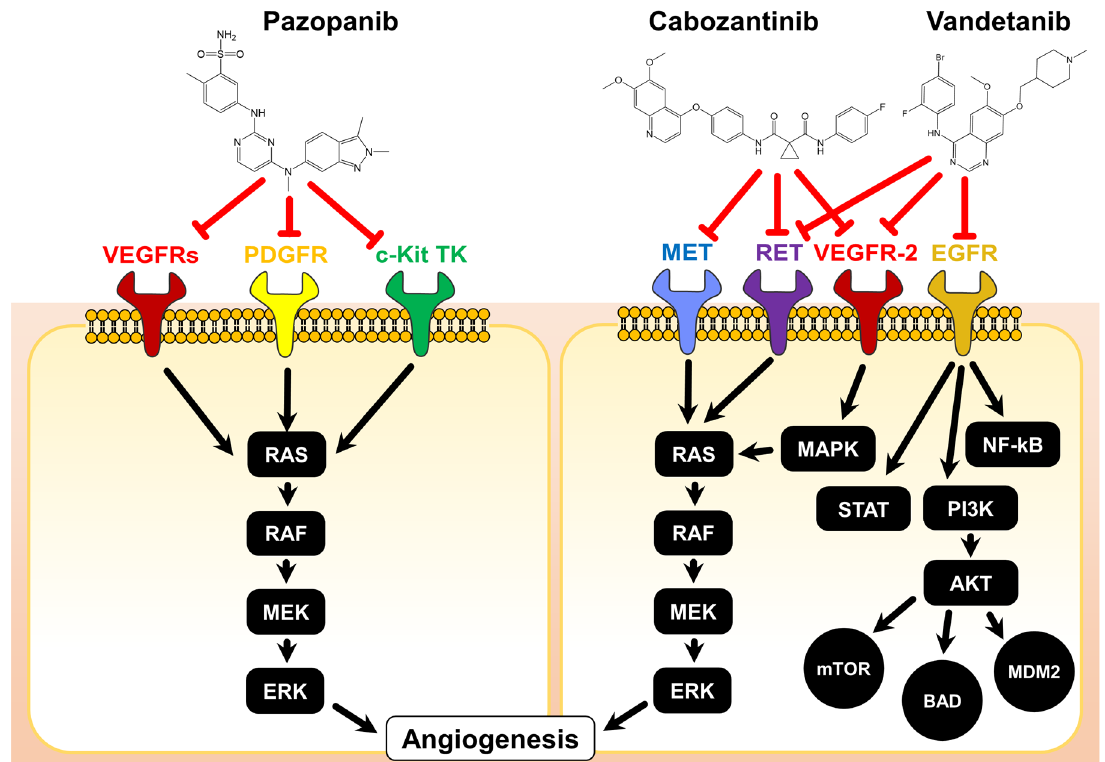
Figure 1. Chemical structures and modes of action of pazopanib, cabozantinib, and vandetanib. The red T-arrows indicate inhibition on receptor signaling. AKT: Protein kinase B; BAD: BCL2 associated agonist of cell death; c-Kit: stem cell growth factor receptor, EGFR: epidermal growth factor receptor; ERK: extracellular regulated kinase, MAPK: mitogen activated protein kinase, MEK: methyl ethyl ketone, MET: methionine, MDM2: mouse double minute 2, mTOR: mammalian target of rapamycin, NF-kB: nuclear factor kappa B, PDGFR: platelet derived growth factor receptor, PI3K: phosphoinositide 3 kinases, RAF: rapidly accelerated fibrosarcoma, RAS: rat sarcoma, RET: rearranged during transfection, STAT: signal transducers and activators of transcription.